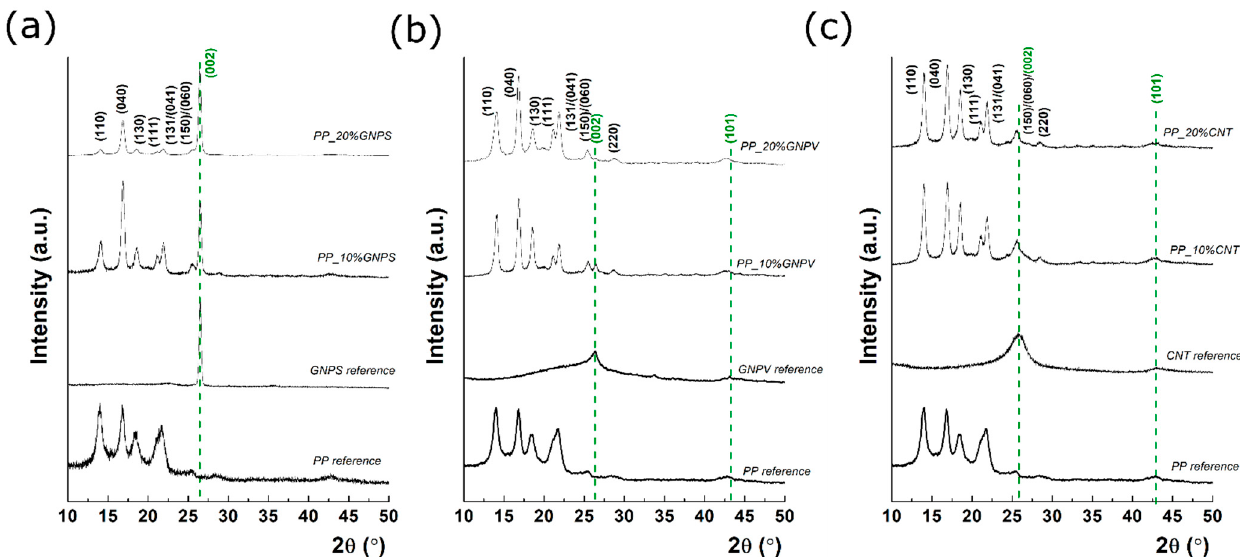
Figure 2. XRD patterns of GNPS ( a ), GNPV ( b ), and CNTs ( c ) pure fillers, pure matrix and the nanomaterials-PP’s matrix-based composites. The olive dashed line was used to indicate the position of the pure GNPS, GNPV, and CNTs peaks.